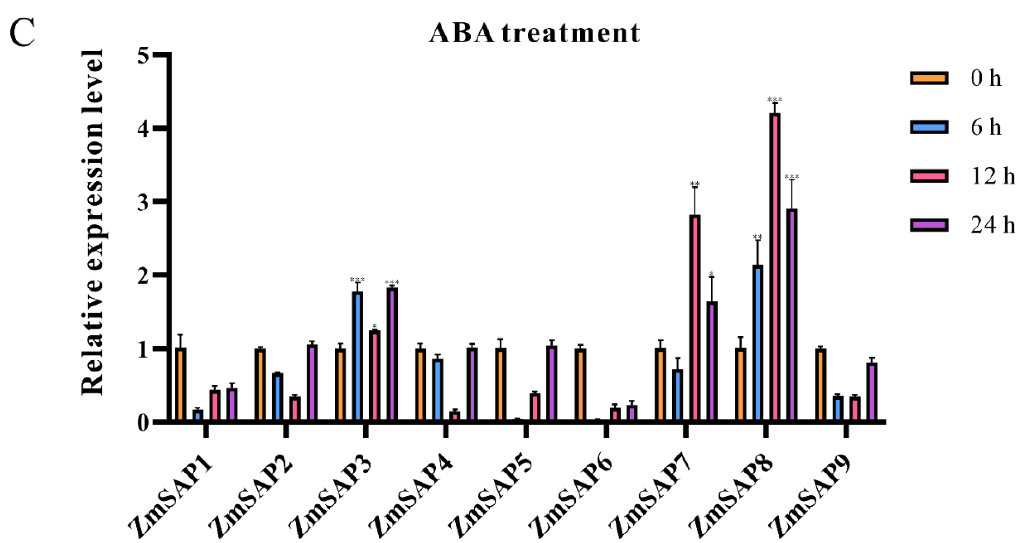
Figure 9. Expression patterns of nine ZmSAP genes with different treatment quantified by qRT- PCR. The relative transcript levels were determined from leaf tissues of maize subjected to ( A ) PEG: polyethylene glycol, ( B ) NaCl: salt, ( C ) ABA: abscisic acid treatment, respectively. The gene names and stress treatments are on the X-axis and relative expression levels on the Y-axis. Relative expression levels of ZmSAP genes were normalized to those of ZmGADPH and ZmActin1 by the 2 − ∆∆ Ct method, and values at 0 h were set to 1.0. Values are presented as the mean ± standard error of values from three independent experiments. Asterisks indicate significant differences compared to the value at 0 h for each gene. (Student’s t-test; * p < 0.05; ** p < 0.01; *** p <